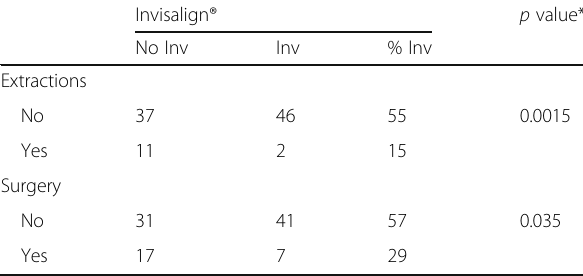
Table 7 Extraction, surgery, and Invisalign®